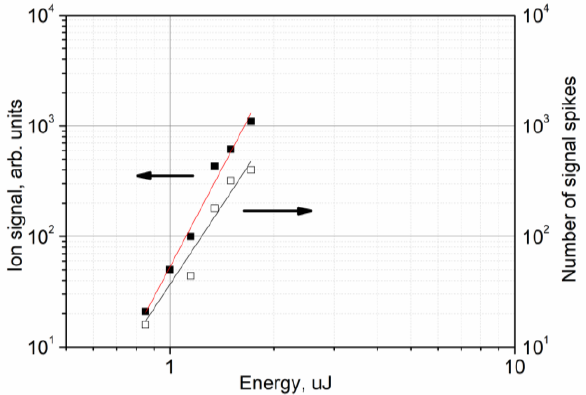
Figure 6. The dependences of the negative Au ion signal spike amplitude (filled squares) and the number of signal spikes (open squares) on the laser pulse energy. Scanning mode. The data were obtained for 500 successive laser pulses.